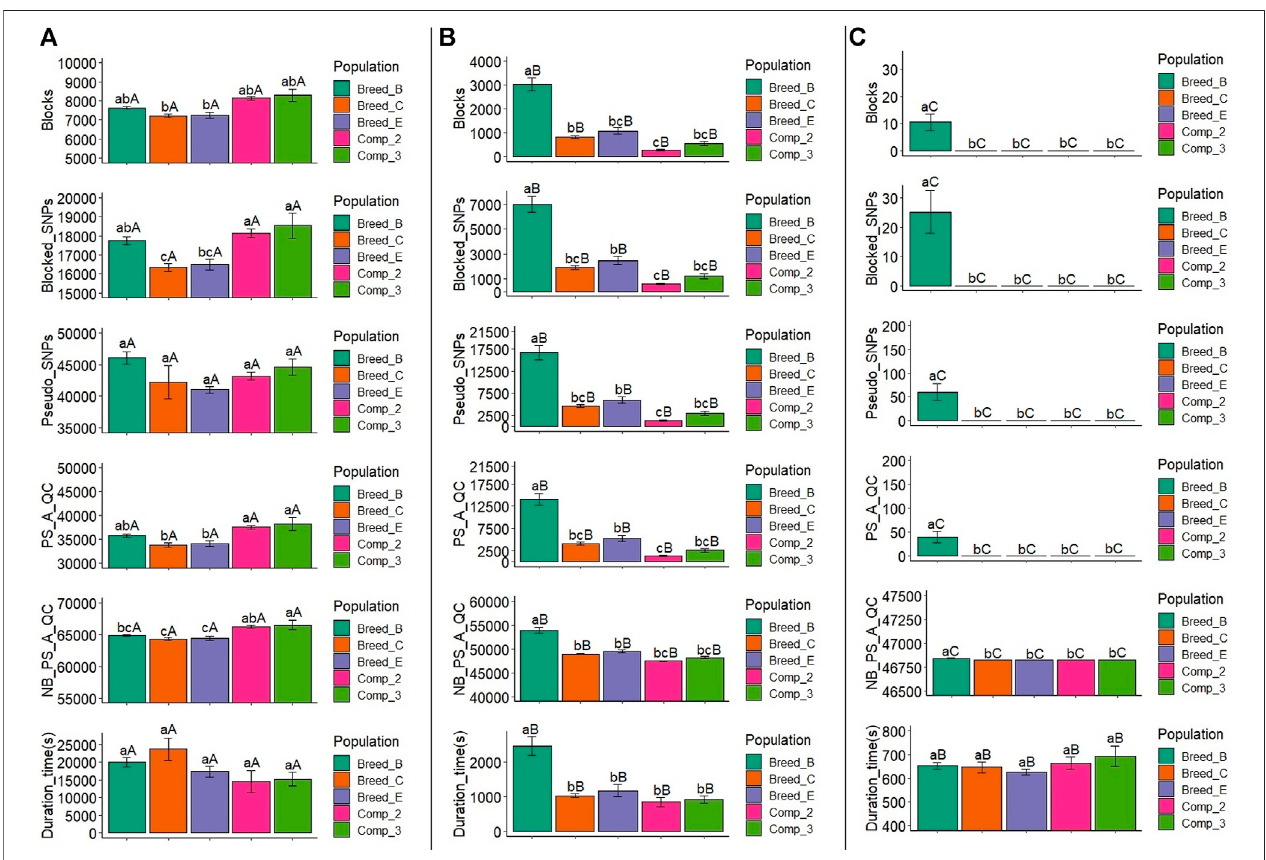
FIGURE 4 | Average number of blocks (Blocks) spanning two or more SNPs, markers within blocks (Blocked_SNPs), pseudo-SNPs (Pseudo_SNPs), pseudo- SNPs after quality control (PS_A_QC), non-blocked SNPs plus pseudo-SNPs after quality control (NB_PS_A_QC), and computing time to obtain the pseudo-SNPs (Comp_time) in the simulation for a trait with low heritability (h 2 (cid:3) 0.10). A, B, and C show the results for the haplotype blocks with LD thresholds of 0.1, 0.3, and 0.6, respectively.Breed_B,Breed_C,andBreed_E:simulatedpurebreedswithdifferentgeneticbackgrounds;Comp_2andComp_3:compositebreedsfromtwoand three pure breeds, respectively. The same lower- or upper-case letters mean no statistical difference comparing populations within LD thresholds and LD threshold across populations, respectively, at 5% signi fi cance level based on the Tukey test.